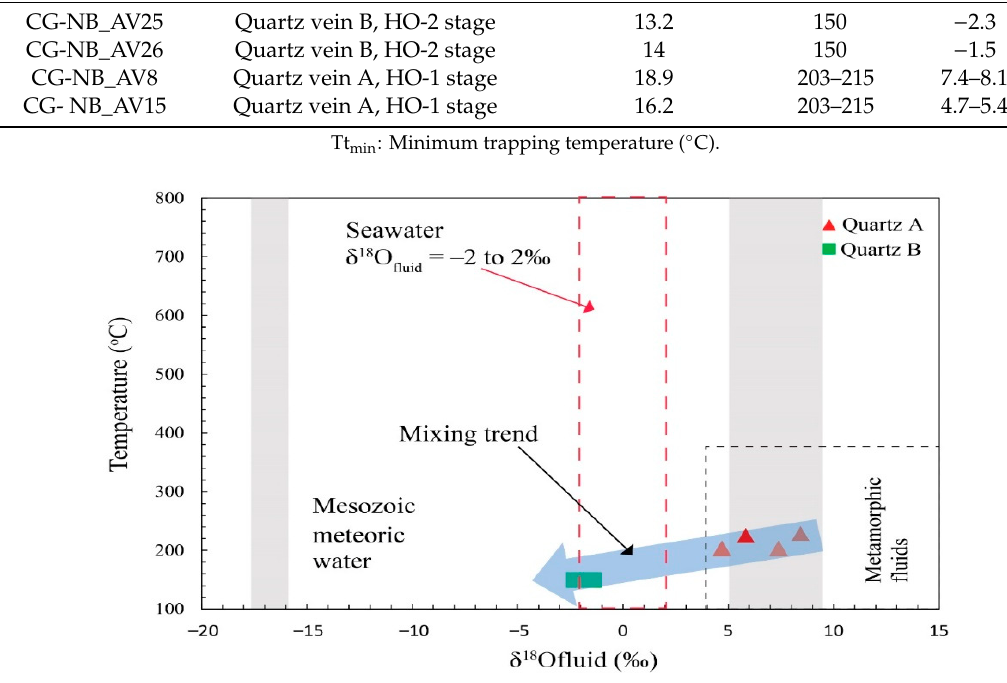
Figure 12. Plot of homogenization temperature versus calculated oxygen isotopic values of the ore-forming fluid in equilibrium with vein quartz A and B in the Nabeba deposit. The compositions of primary magmatic water [23,24], metamorphic fluids [25], the Mesozoic meteoric water in the northern Xilamulun district, northeastern China [26], and seawater [27] are also shown for comparison.